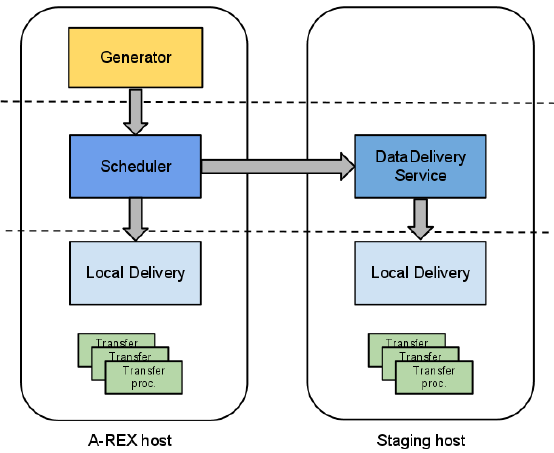
Figure 2: ARC multihost data delivery